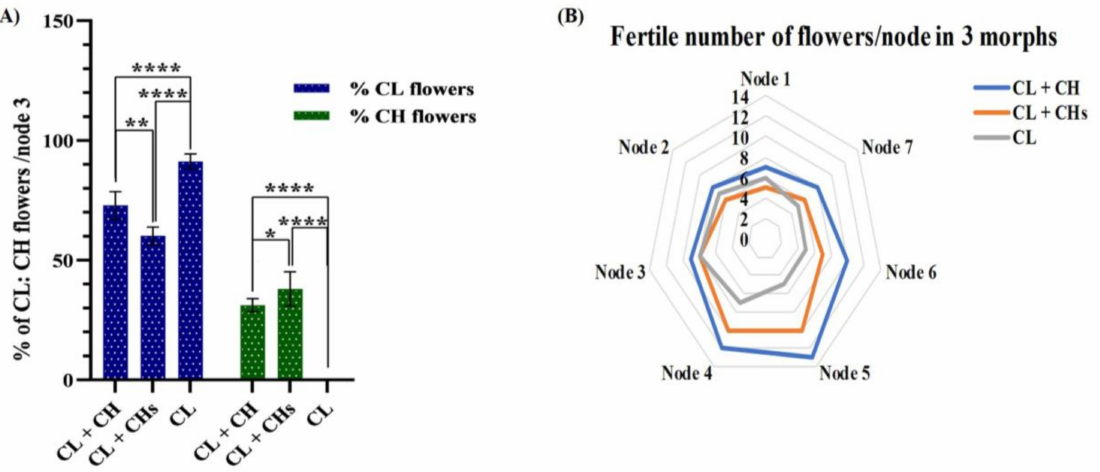
Figure 2. Diversity in CL: CH flowers in different nodes/morphs and its statistical model ( A ) Percent- age of CL: CH flowers in node 3/morph. p -value: * = 0.021, ** = 0.002 and **** ≤ 0.0001 ( B ) Statistical model showing the number of total fertile flowers (CL and